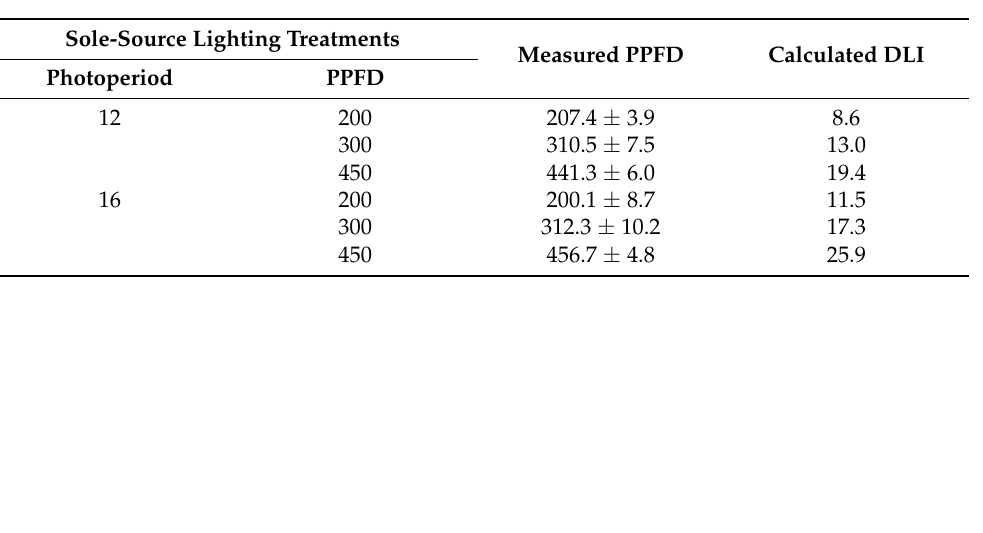
Table 1. Photoperiod (hour · d − 1 ), photosynthetic photon flux density (PPFD; µ mol · m − 2 · s − 1 ),